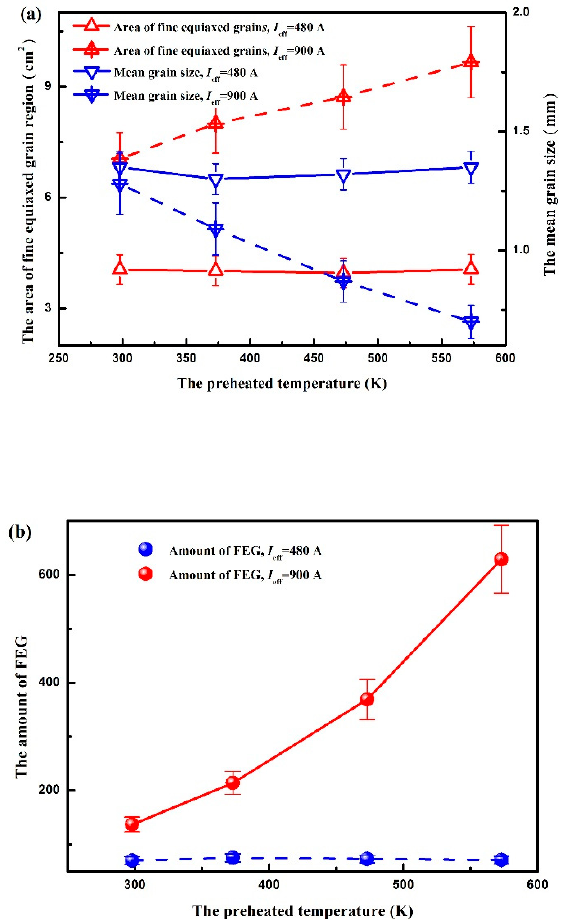
Figure 5. ( a ) The area of fine equiaxed grain region and the mean grain size in each of the ingots under electropulsing with 480 A and 900 A as a function of the preheating temperature of mold and ( b ) the amount of FEG in each of ingots under electropulsing with 480 A and 900 A as a function of their corresponding preheating temperature of mold.